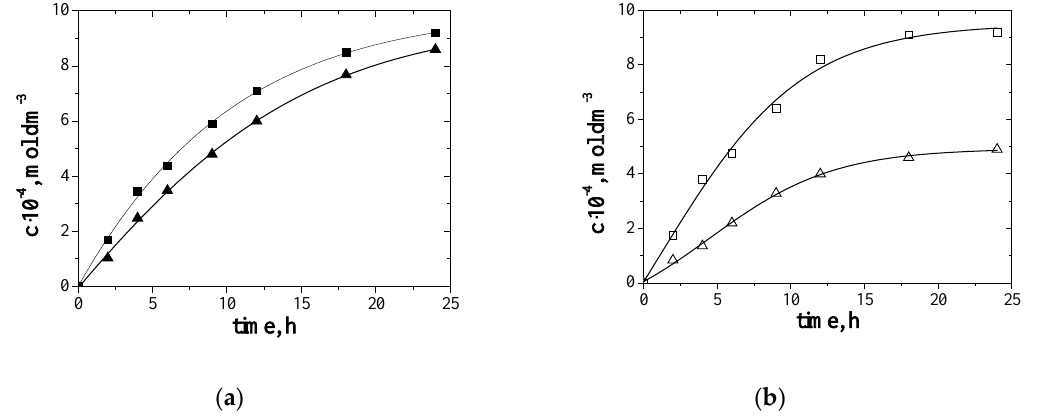
Figure 4. The changes of Zn(II) ( ■ , □) and Ag(I) ( ▲ , ∆ ) ions concentration over time during transport across PIMs with ( a ) ( ■ , ▲ ) 1-hexylifiguremidazole ( 1 ) or ( b ) (□, ∆) 1 -hexyl-2-methylimidazole (2 ). To calculate the value of the rate constant ( k ) for each membrane, relationships ln( c / c o ) = f(t) were plotted (Figure 5).